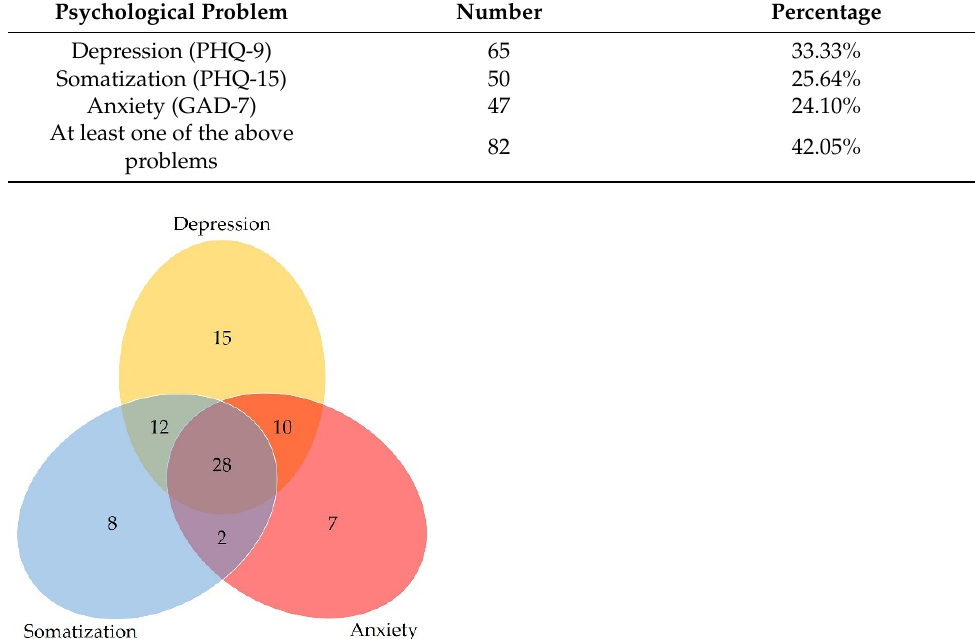
Table 4. Baseline characteristics of the participants and subgroup analysis.